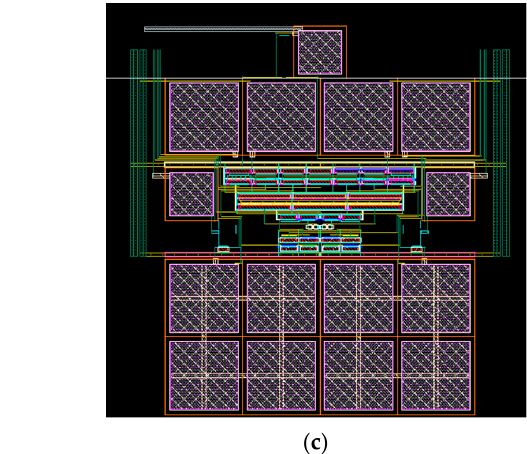
Figure 16. Stand-alone envelope-detector outputs of V in,env = {1, 10, 20, 30} µV.